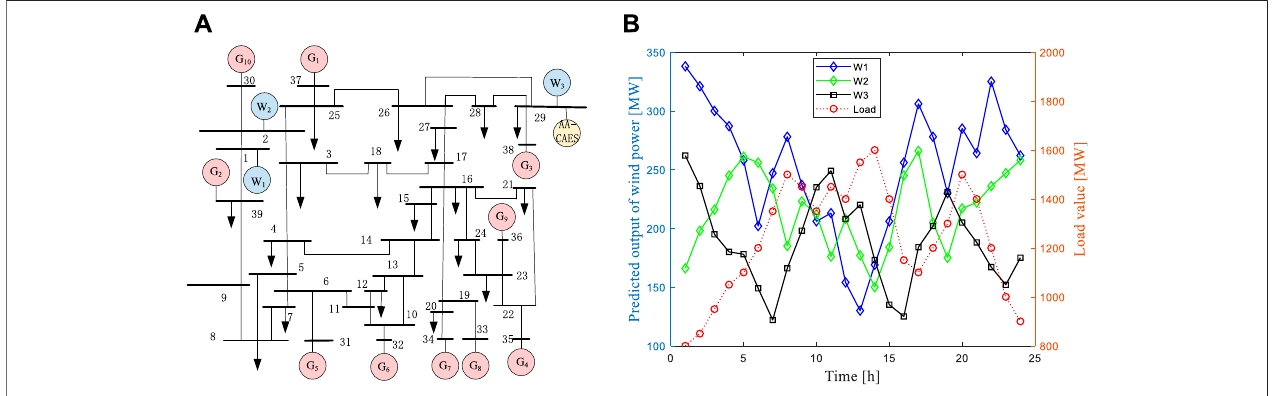
FIGURE 2 | Example node system diagram and wind farm output prediction and load curve: (A) node system diagram; (B) wind farm output prediction and load curve.